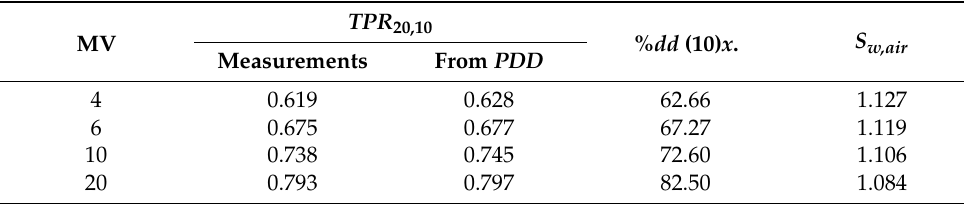
Table 2. The main dosimetry parameters for the photon beams studied, including: S w,air , TPR 20,10 , and % dd (10) x .